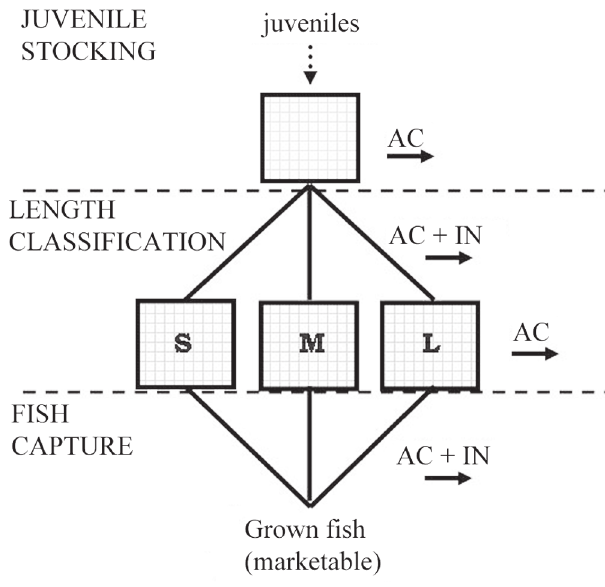
Fig. 4. Main events along the production system ( i.e . juvenile stocking, length classification and fish capture) and the moments in which escapes occur (solid arrows: AC = accidental; IN = intentional). S = small-sized fish; M = medium- sized; L =